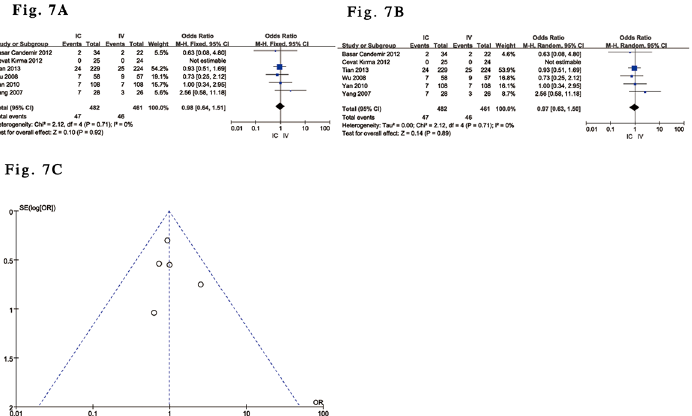
Fig 7. Forest plot of bleeding events in ACS patients treated with IC vs. IV administration of tirofiban. (A). Forest plot for bleeding events based on a fixed-effects model in ACS patients treated with IC vs. IV administration of tirofiban. (B). Forest plot for bleeding events based on a random-effects model in ACS patients treated with IC vs. IV administration of tirofiban. (C). Funnel plot of bleeding events used to identify evidence of publication